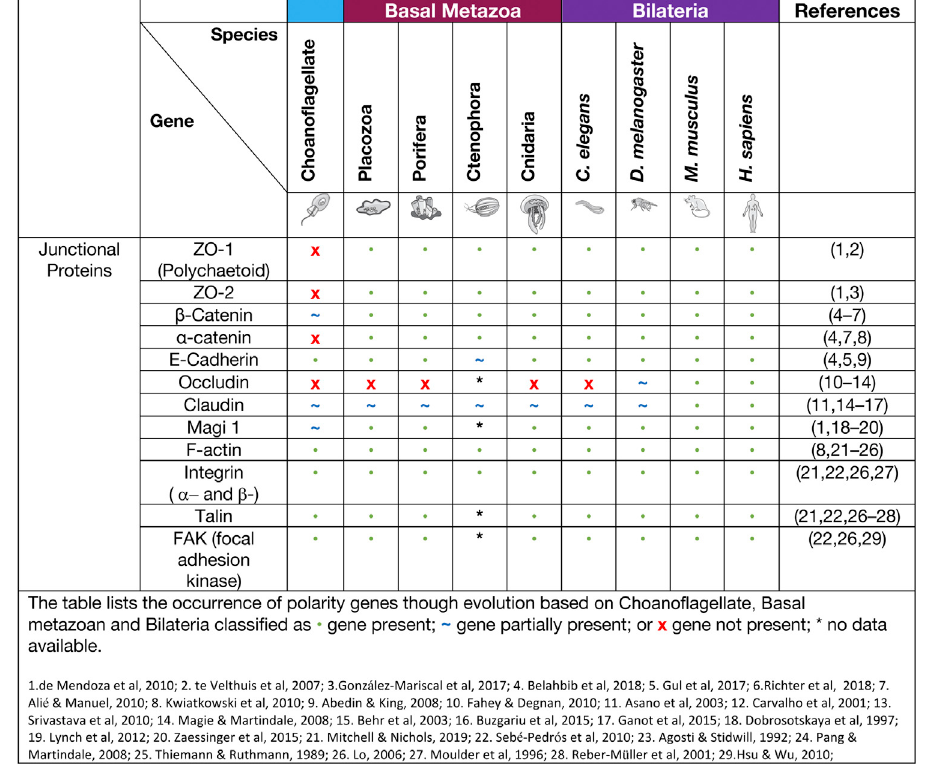
TABLE 4 Junctional